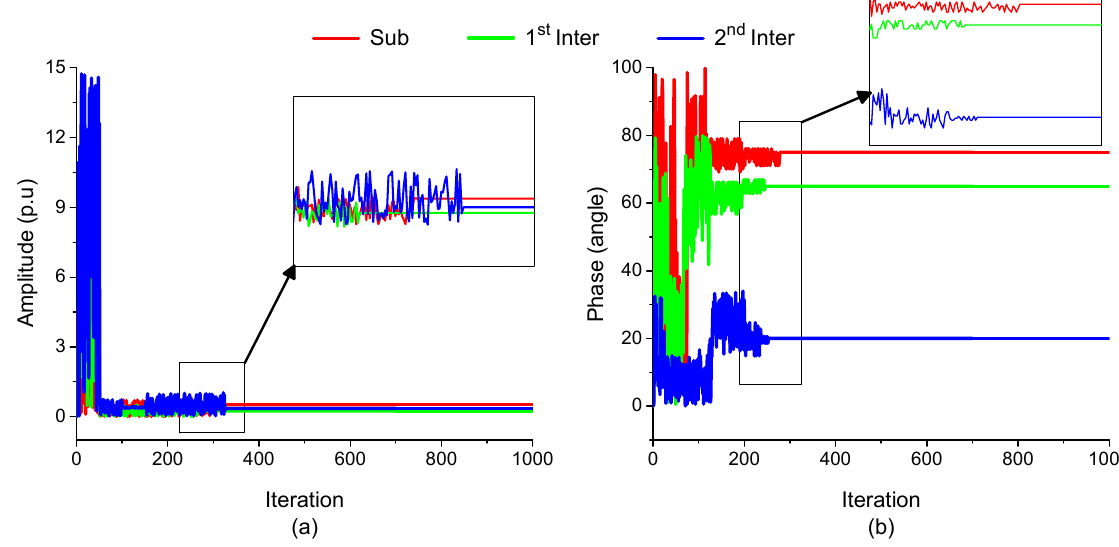
Figure 16. Variation in estimated ( a ) amplitude and ( b ) phase in the course of iterations for the sub and inter